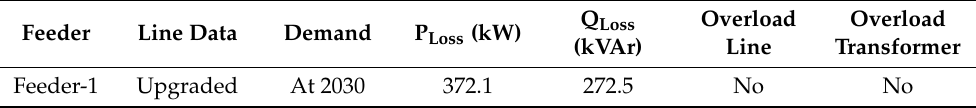
Table 6. Load flow results for upgraded existing network in peak load in